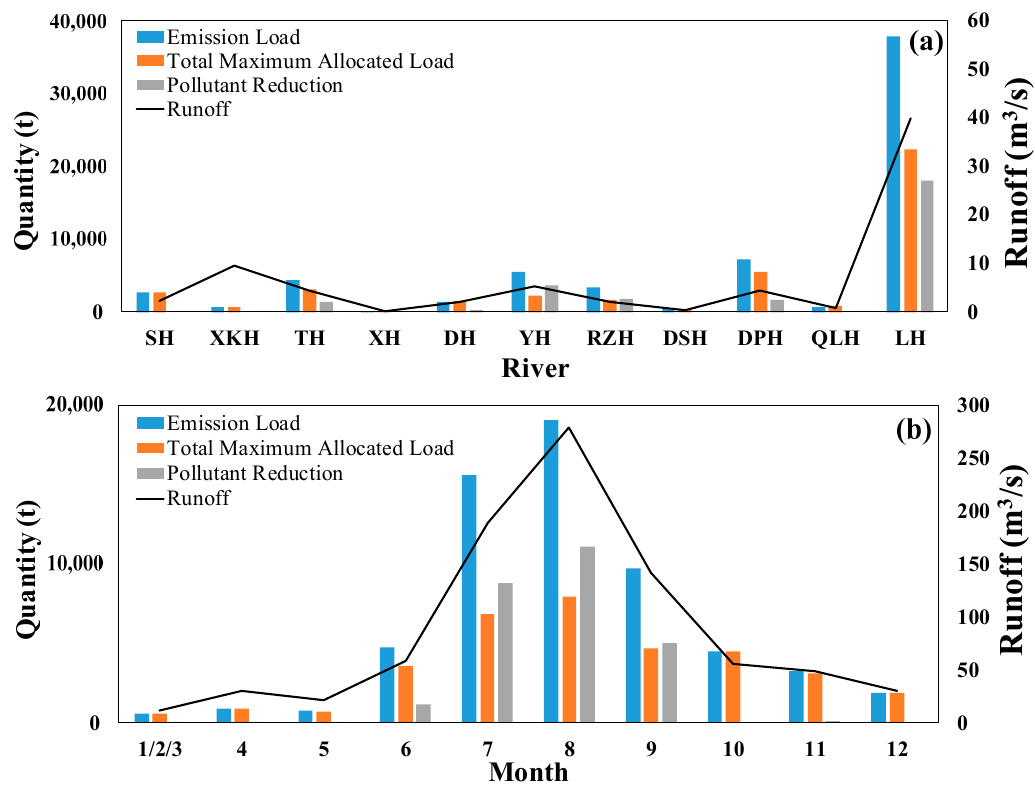
Figure 8. ( a ) The year-round emission load, TMAL, pollutant reduction, and runoff of 11 seagoing rivers in QHD sea in 2013. ( b ) Monthly average variations of emission load, TMAL, pollutant reduction, and runoff of all rivers in QHD sea during 2013.